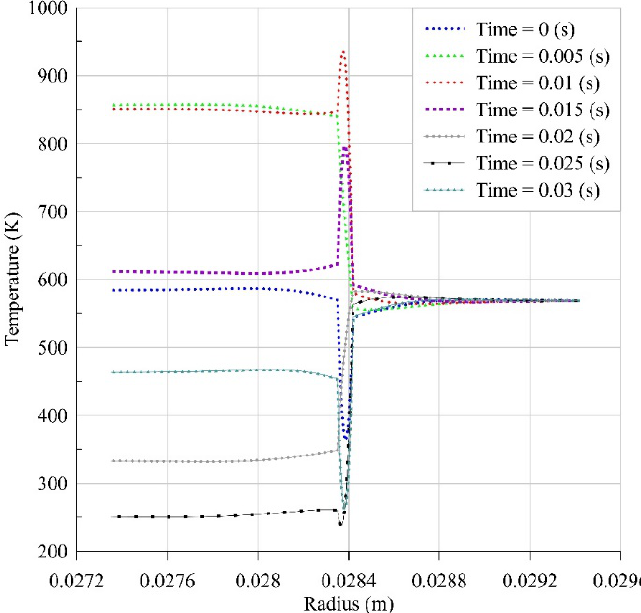
Figure 11. Flow temperature in the gap = 70 μm.